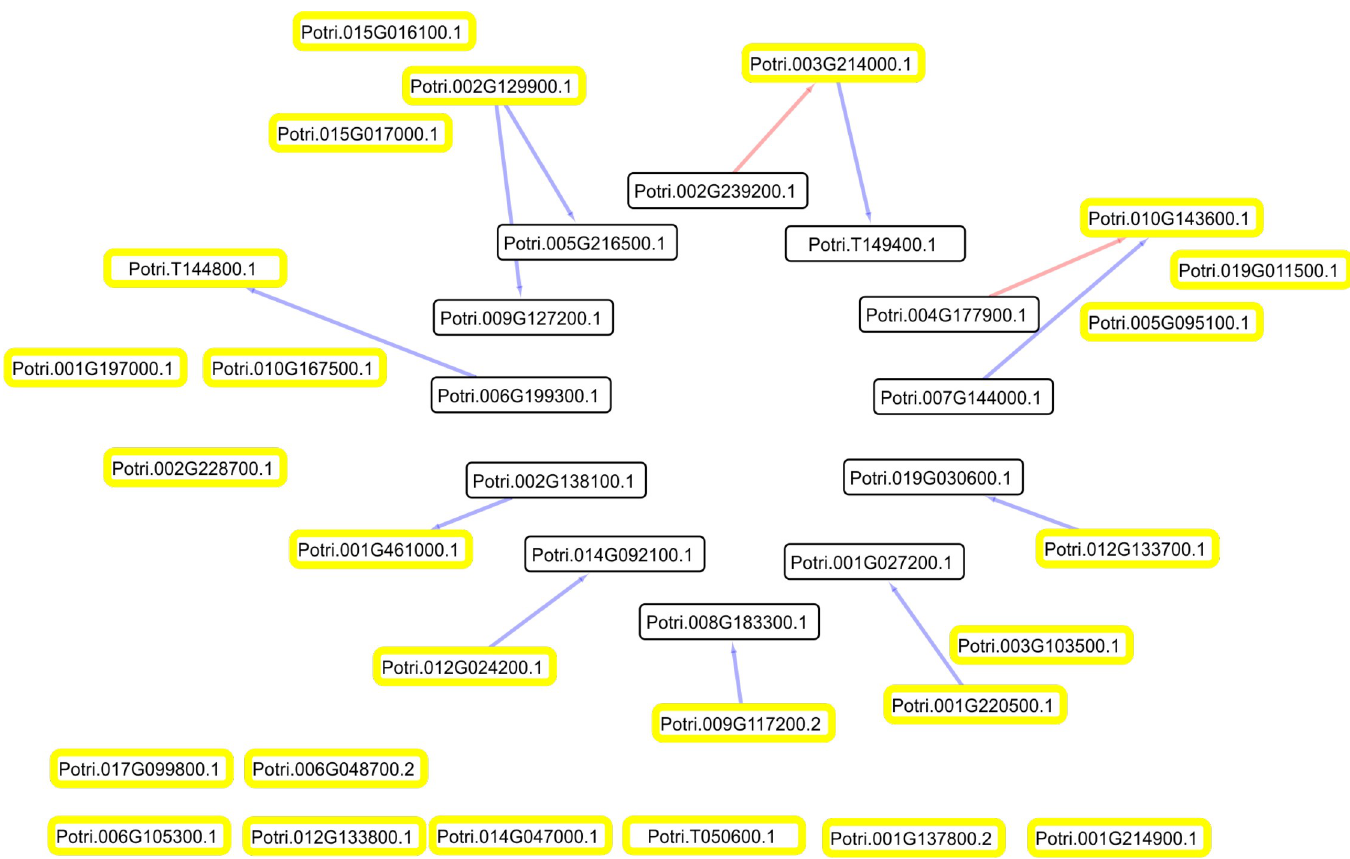
Fig 2. Co-expression network between aluminium-regulated transcription factors. Co-expression network between transcription factors with transcriptional variation greater than 100% due to effect of stress and genes correlated with the same level of variation. Network constructed with correlations with ρ � |0 . 8| . Circles with yellow borders refer to transcription factors, blue lines refer to positive correlations and red lines to negative